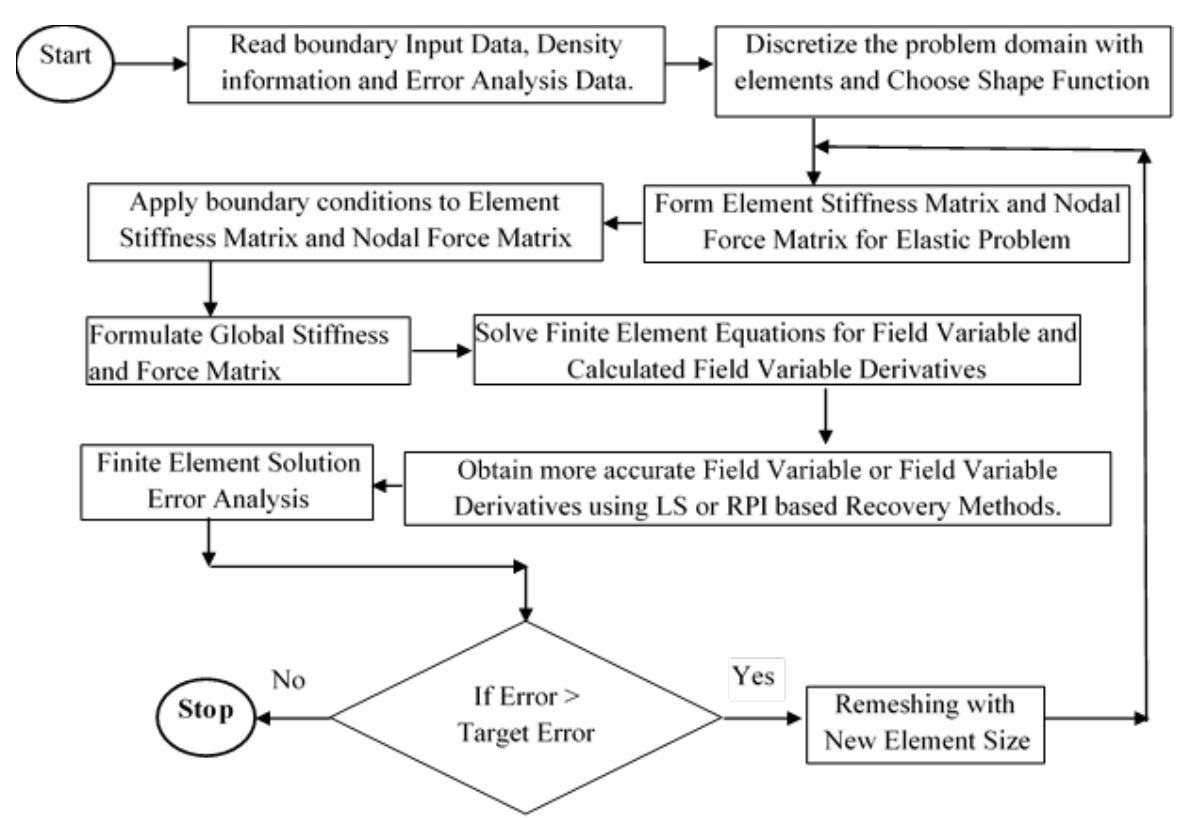
Figure 1. Least square and RPI recovery techniques coupled adaptive elastic finite element analysis flow chart.